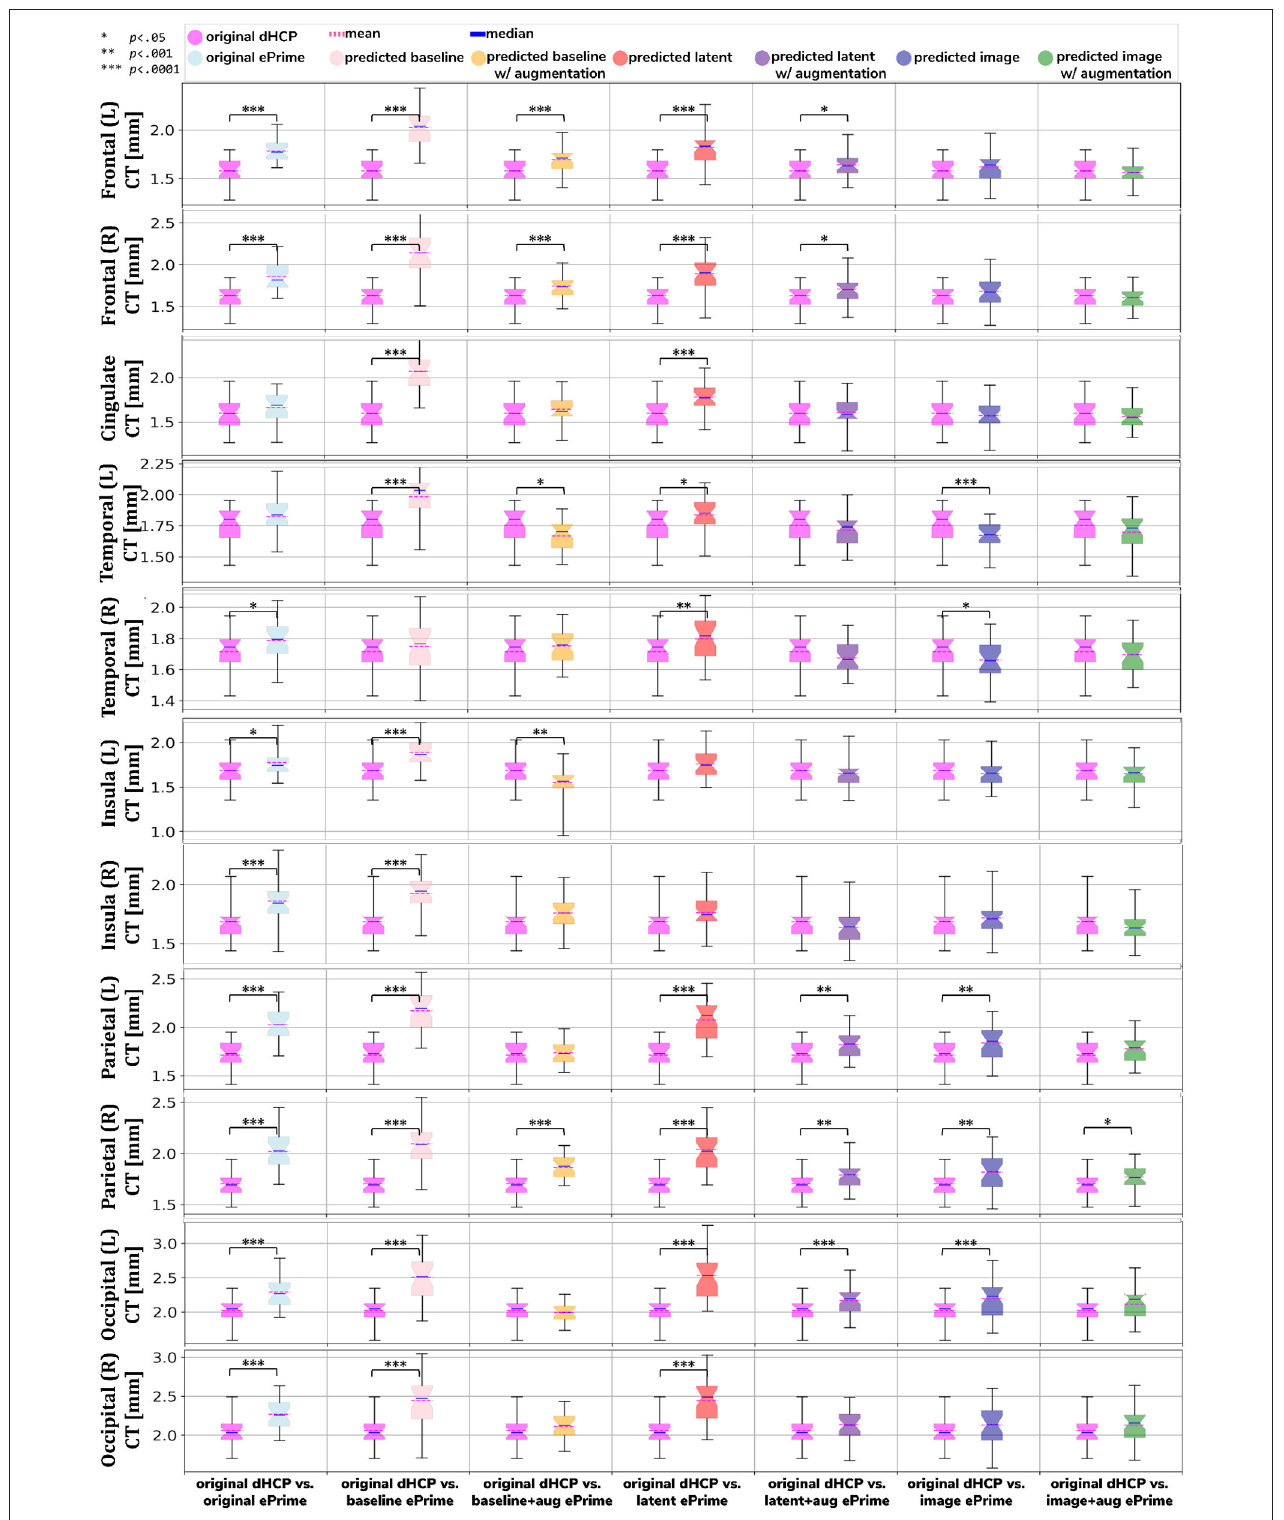
FIGURE 8 | Comparison of local mean cortical thickness measures between original Draw-EM dHCP segmentations and original Draw-EM ePrime segmentations (first column), or between original Draw-EM dHCP segmentations and ePrime segmentations obtained with the six trained models (columns 2–7). Linear regressions were performed in the comparable data subsets testing the effects of cohort on local cortical thickness measures, controlling for PMA, GA, and sex (CT ∼ cohort + PMA + GA + sex). The asterisks indicate a statistically significant effect of cohort in the linear regression.